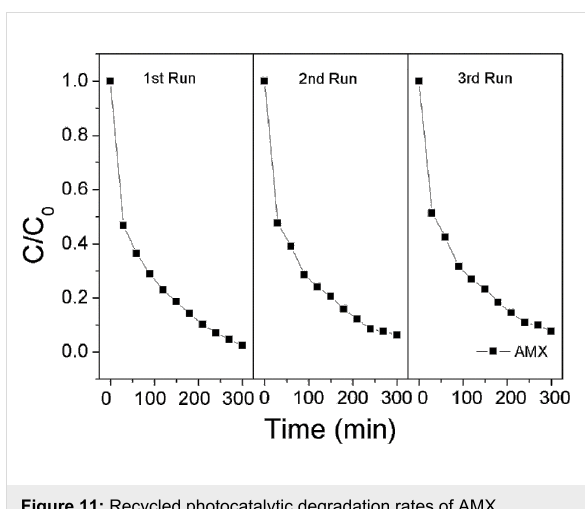
Figure 11: Recycled photocatalytic degradation rates of AMX (0.5 wt % Pd/TiO 2 ).